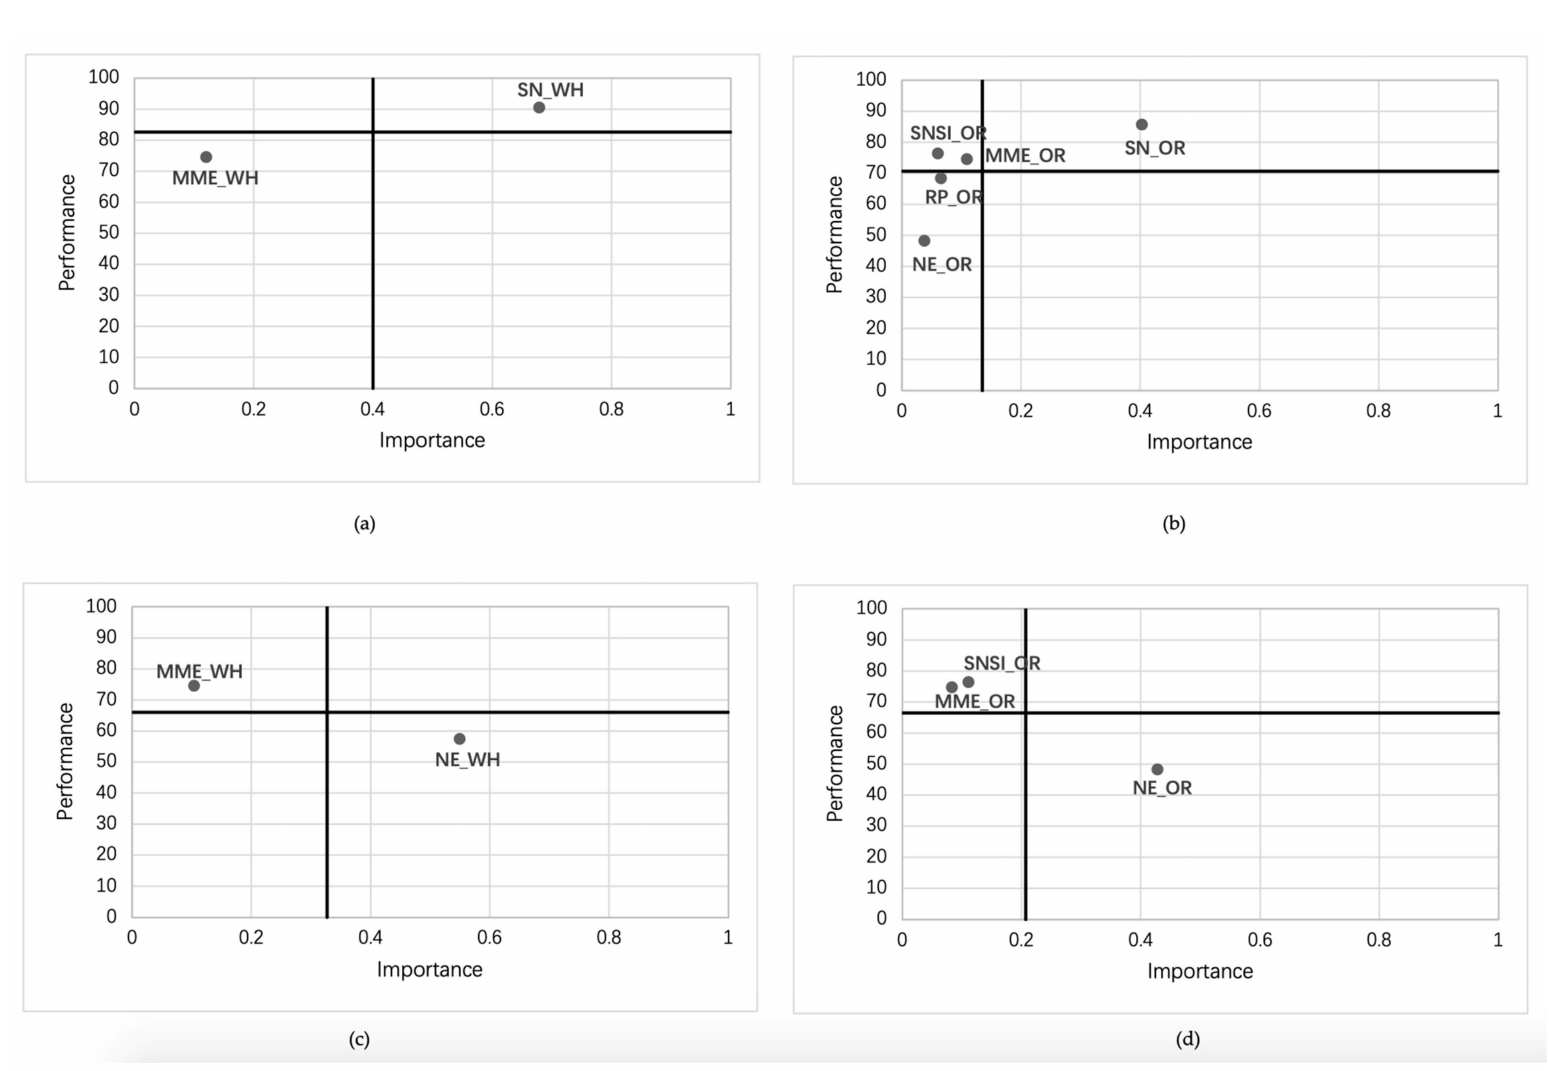
Figure 4. Results of IPMA. ( a ) IPMA for PB (Wuhan); ( b ) IPMA for PB (Other regions); ( c ) IPMA for EPI (Wuhan); ( d ) IPMA for EPI (Other